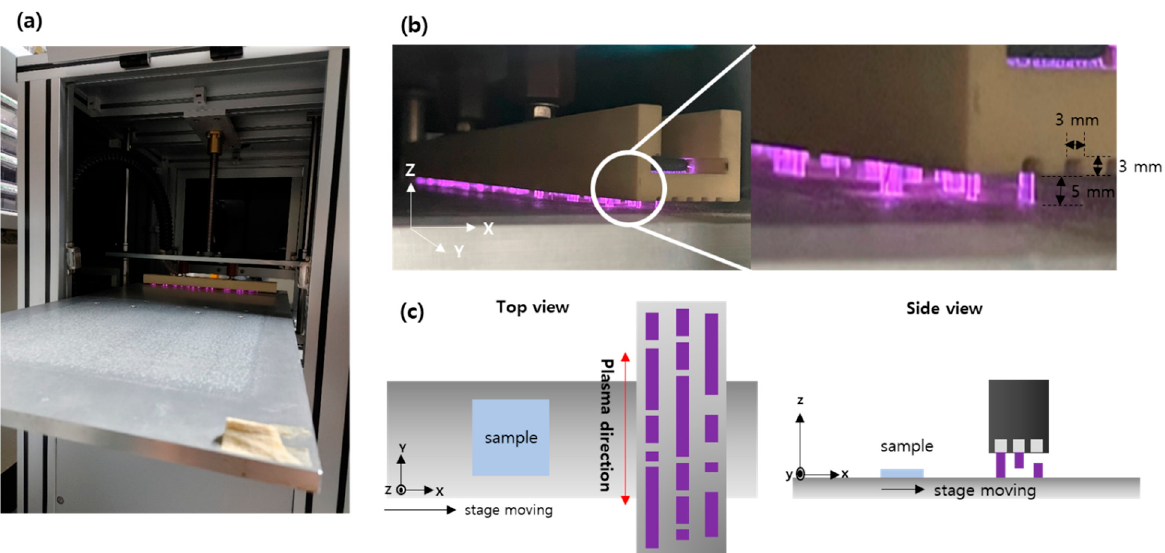
Figure 2. ( a ) Atmospheric plasma discharging machine used for this study. ( b ) Photograph of the plasma discharging on the alignment layer. It can be easily seen that the plasma is discharged with an anisotropic shape due to the column-shaped ceramic plate. ( c ) Schematic illustration of the experimental setup where the anisotropic plasma (AP) is discharged on the sample surface.